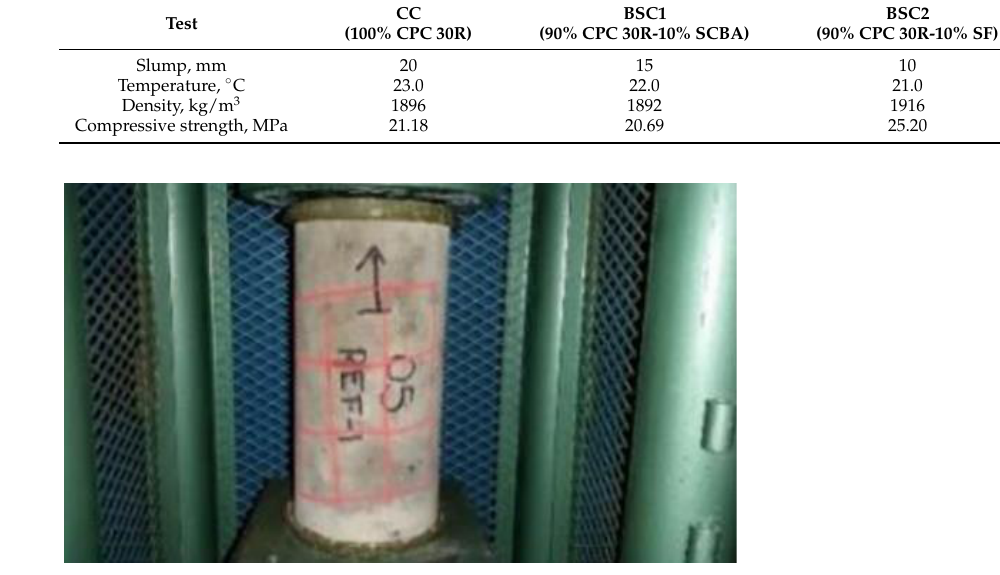
Figure 1. Experimental tests setup of compressive strength test of concrete. Table 4. Physical properties conventional concrete and binary sustainable concretes.